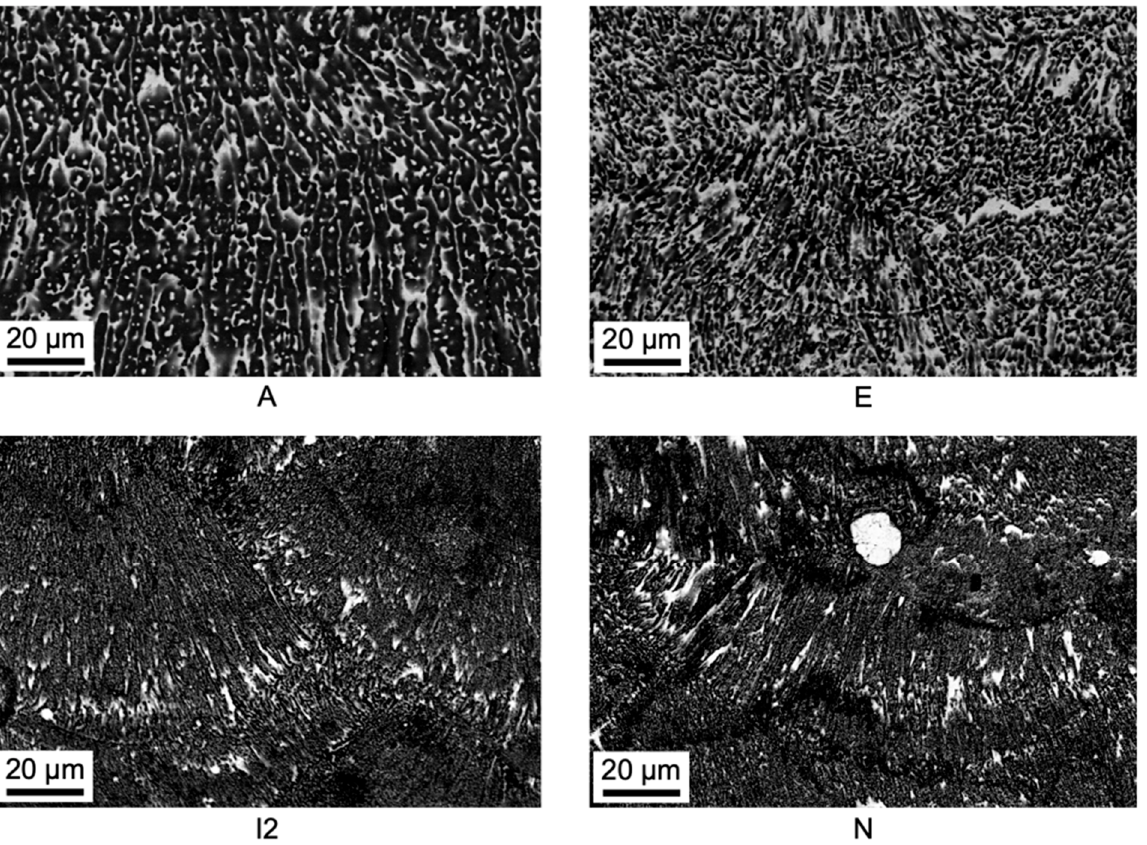
Figure 8. SEM micrographs (BSE) of samples A, E, I2, and N at 3000x magnification. In all the samples, round-shape Sn particles with diameter of ∼ 15 µm are observed (e.g., see sample N in Figure 8 and samples I and E in Figure 9). These particles seldomly show inner porosities (Figure 9b). Focusing on cracks (Figure 9), it is possible to notice that they can be partially or fully filled with Sn.